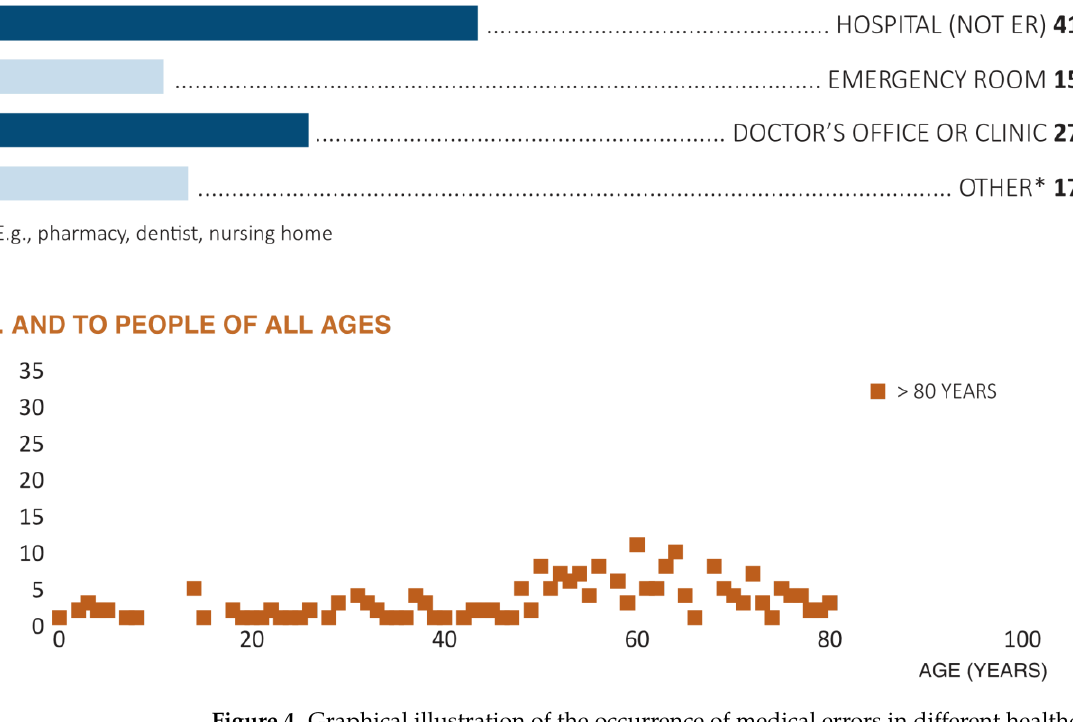
Figure 4. Graphical illustration of the occurrence of medical errors in different healthcare settings along with the people of all ages [57]. Abbreviations used: ER, Emergency Room.